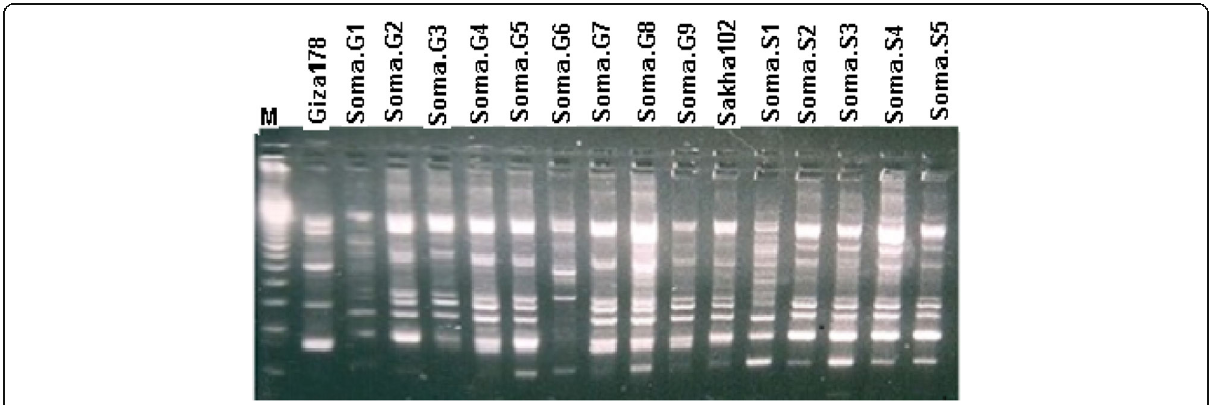
Fig. 3 RAPD polymorphism in rice cultivars, Giza178 and Sakha102, and their somaclons using primer 9